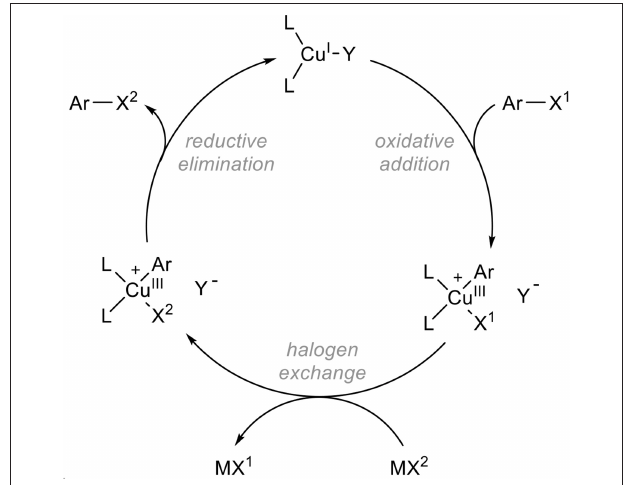
FIGURE 6 | Proposed mechanism for the copper-catalyzed aromatic Finkelstein reaction.